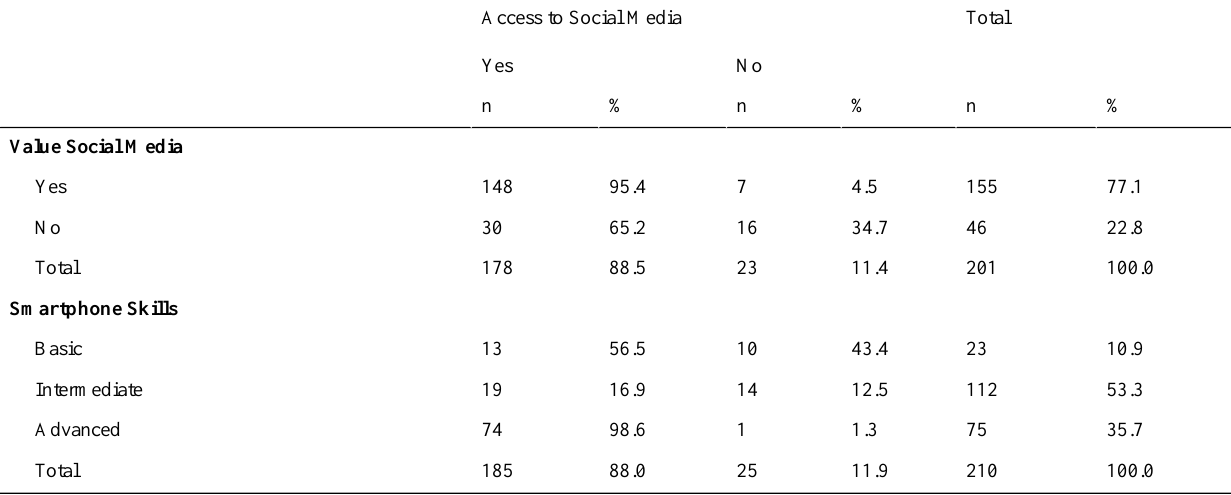
Table 3. Cross tabulation comparing number of students accessing social media with smartphones, and the number of students who find social media valuable for learning, and the number of students who accessed social media with smartphones and students’ skills with the smartphone (chi-square P